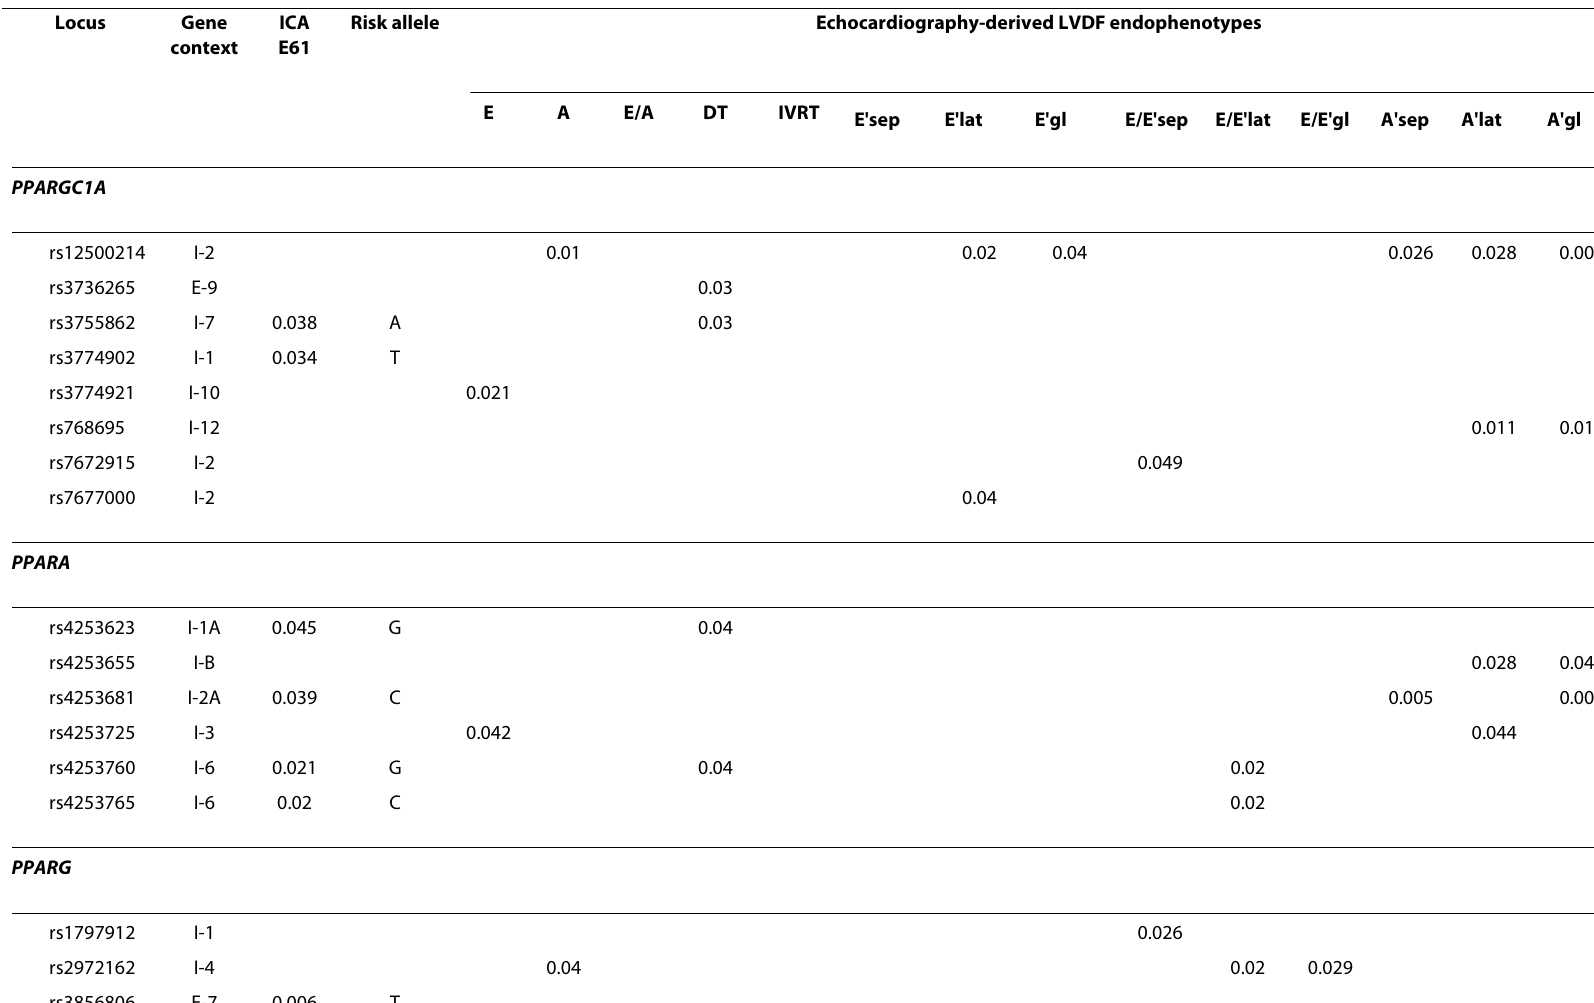
Table 5: P-values of genetic association study for candidate SNPs with lent LVDD trait: ICA and 14 echocardiography-derived endophenotypes. Locus Gene ICA context